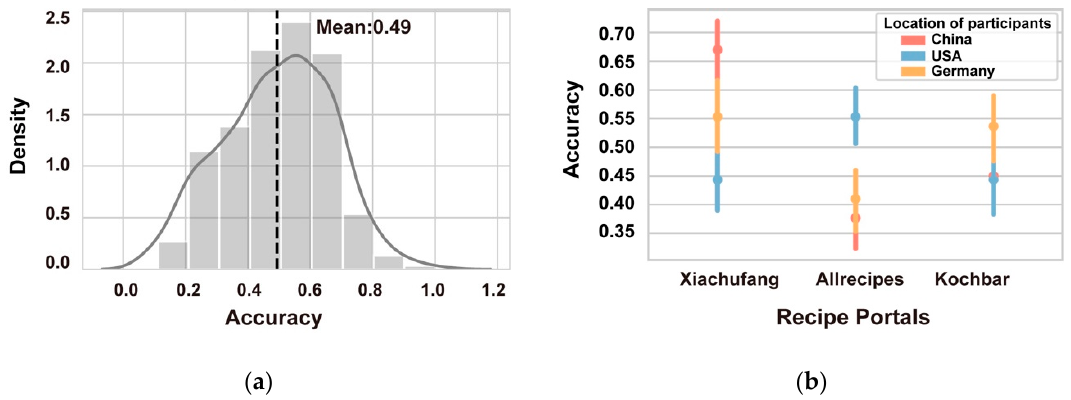
Figure 4. Human performance on food origin classification task. ( a ) Distribution and mean value of participant accuracy. ( b ) Mean value and error bar for participant accuracy for each recipe portal, grouped by participant origin.